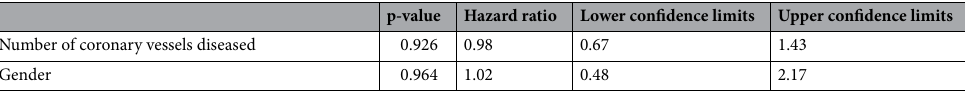
Table 5. Predictors of death in Cox proportional hazards regression analyses. (Model A) DES generation was an independent predictor of death in the entire study population. (Model B) NT-proBNP was an independent predictor of death. (Model C) A significant interaction between NT-proBNP and DES generation. (Model D) Association between DES generation and death in patients with above median NT-proBNP. (Model E) No association between the DES generation and death in patients with below median NT-proBNP. CCS Canadian Cardiovascular Society, NYHA New York Heart